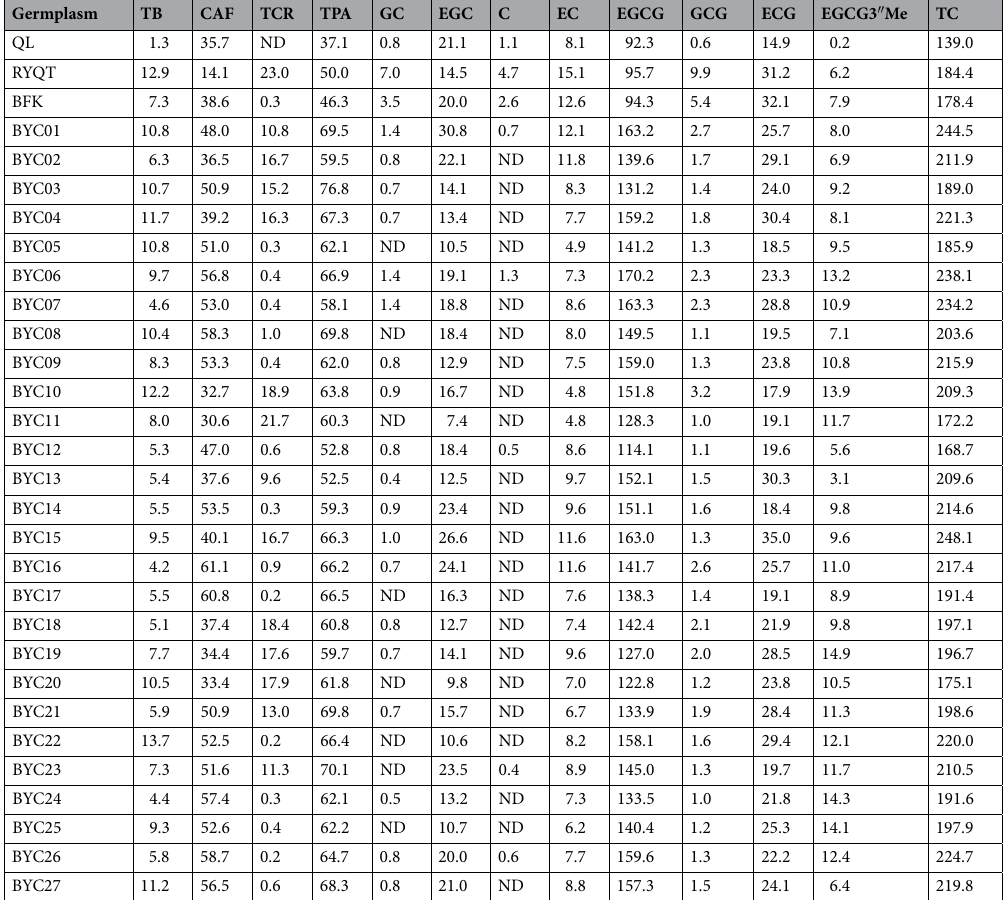
Table 1. Contents of purine alkaloids and catechins in 27 Baiyacha indivduals (mg/g). The values are the mean of three independent determinations. QL, ‘Qilan’; RYQT, ‘Ruyuan Qunti’; BFK, ‘Benifuuki’; BYC, ‘Baiyacha’. TB, theobromine; CAF, caffeine; TCR, theacrine; TPA, total purine alkaloids; GC, ( + )-gallocatechin; EGC, ( − )-epigallocatechin; C, ( + )-catechin; EC, ( − )-epicatechin; EGCG, ( − )-epigallocatechin-3-gallate; GCG, ( − )-gallocatechin-3-gallate; ECG, ( − )-epicatechin-3-gallate; EGCG3 ″ Me, 3 ″ -methyl-epigallocatechin gallate; TC, total catechins. ND, not